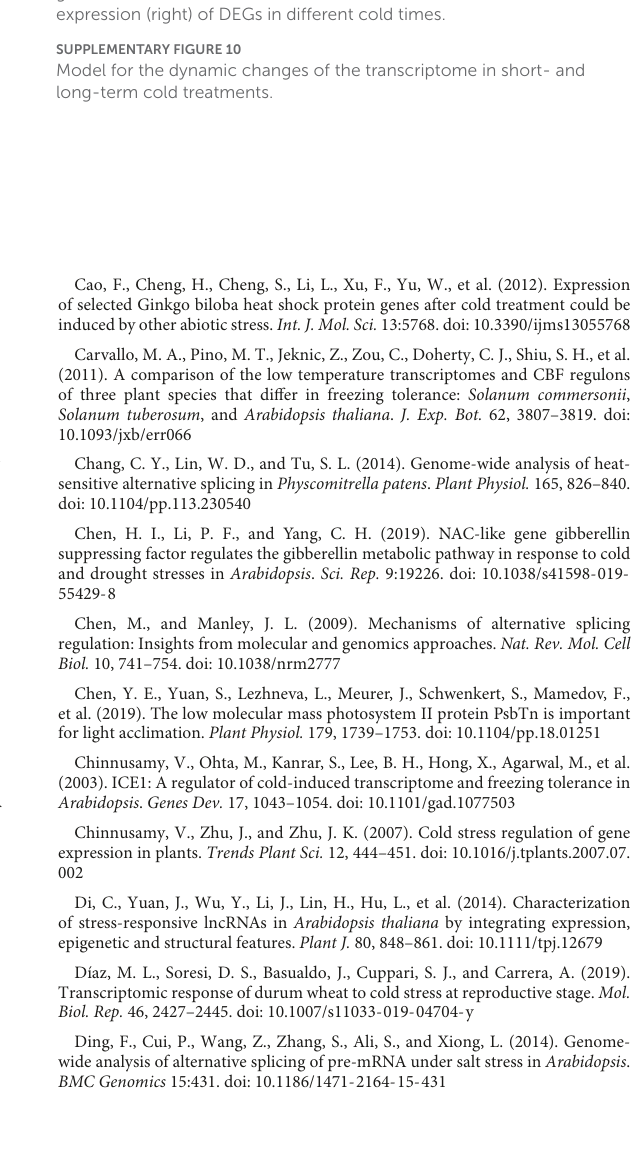
relative expression (right) of DEGs in different cold